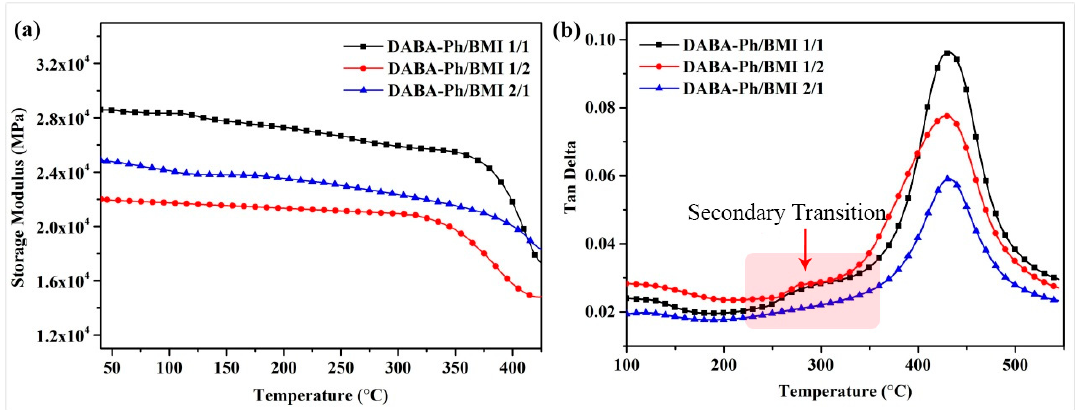
Figure 7. Dynamic mechanical properties of DABA-Ph/BMI composite laminates: ( a ) storage modulus ( b ) Tan δ . Table 3. Storage modulus and glass-transition temperature ( T g ) of DABA-Ph/BMI composite laminates. Sample Initial Storage Modulus at 50 ◦ C (MPa) T g ( ◦ C) DABA-Ph # 28,975 382 DABA-Ph/BMI-2-1 24,781 430.1 DABA-Ph/BMI-1-1 28,556 430.9 DABA-Ph/BMI-1-2 21,944